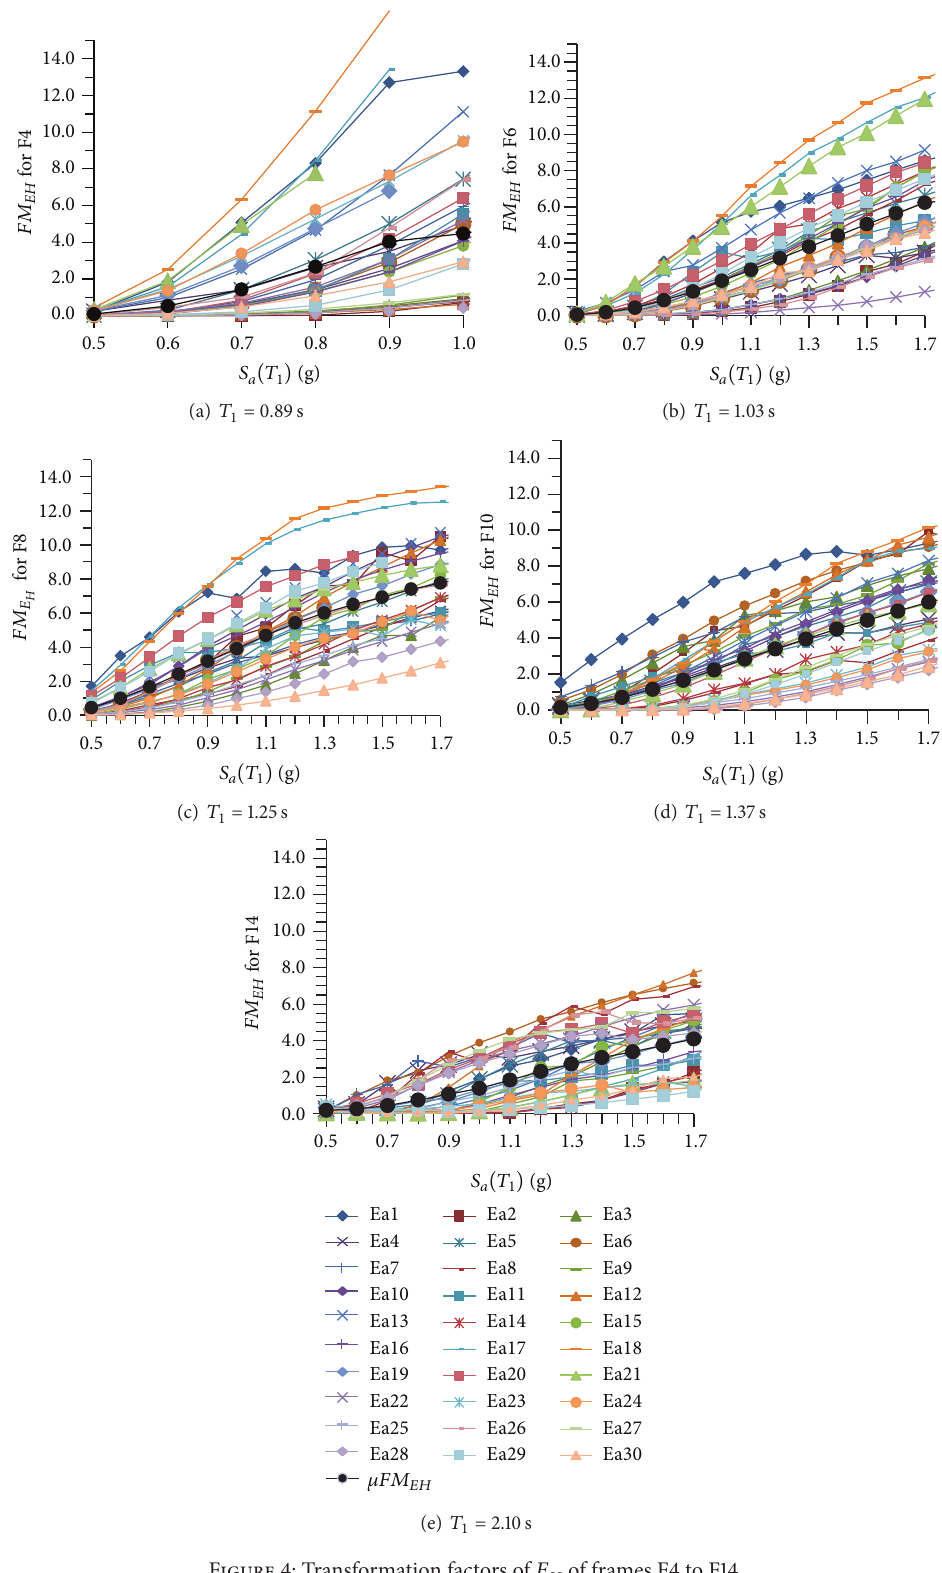
Figure 4: Transformation factors of 𝐸 𝐻 of frames F4 to